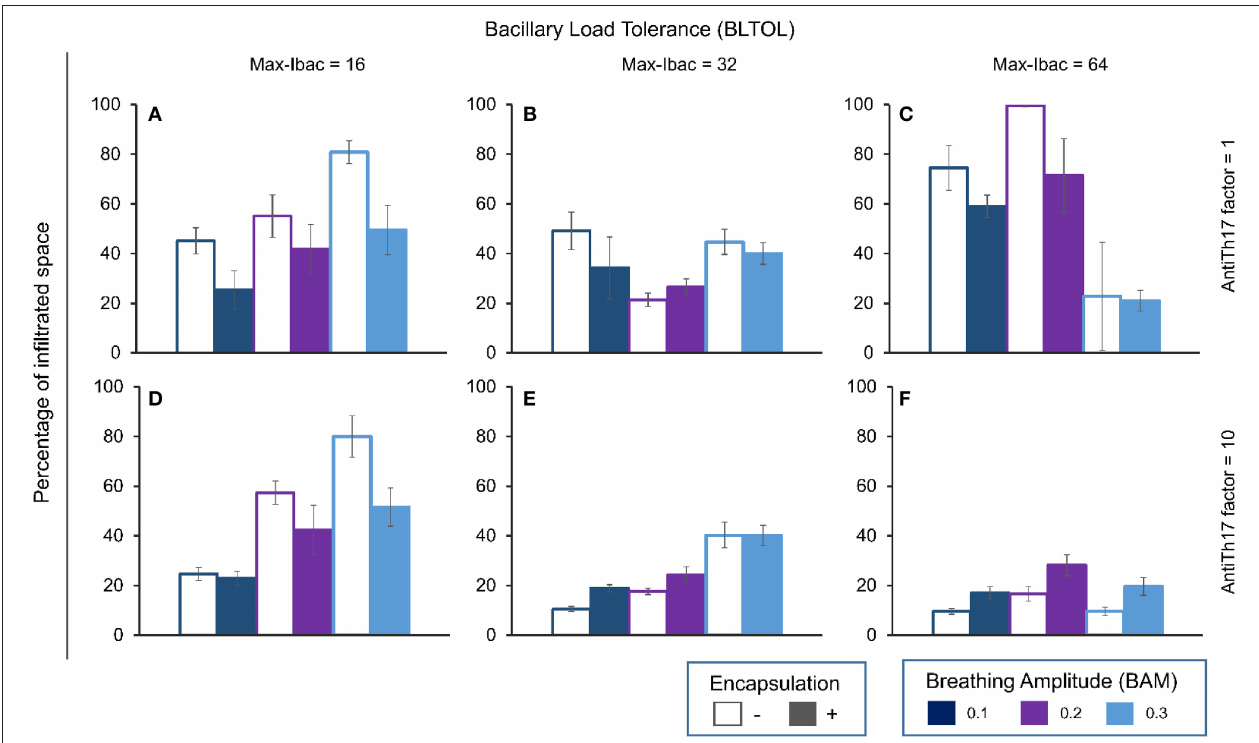
FIGURE 8 | Influence of different parameters on the percentage of infiltrated space at day 42. Maximum bacillary load per macrophage (BLTOL): 16 (A,D) , 32 (B,E) , 64 (C,F) . AntiTh17 factor: 1 (A–C) , 10 (D–F) Encapsulation factor: − = no encapsulation, + = encapsulation. Breathing amplitude (BAM): 0.1, 0.2, 0.3. Bars indicate the mean of 10 runs.